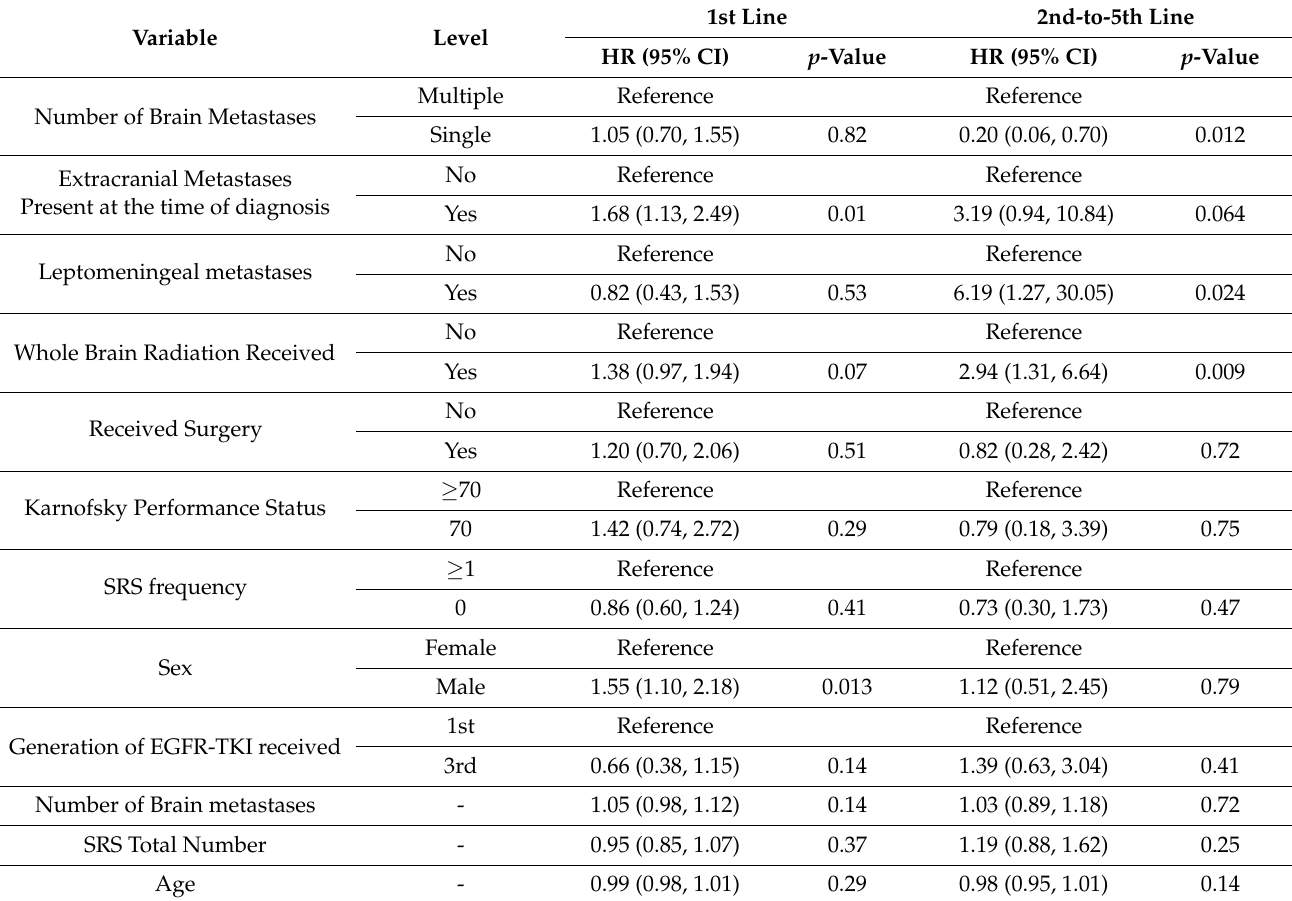
Table 9. Univariable Cox Proportional Hazards modeling of progression-free survival.